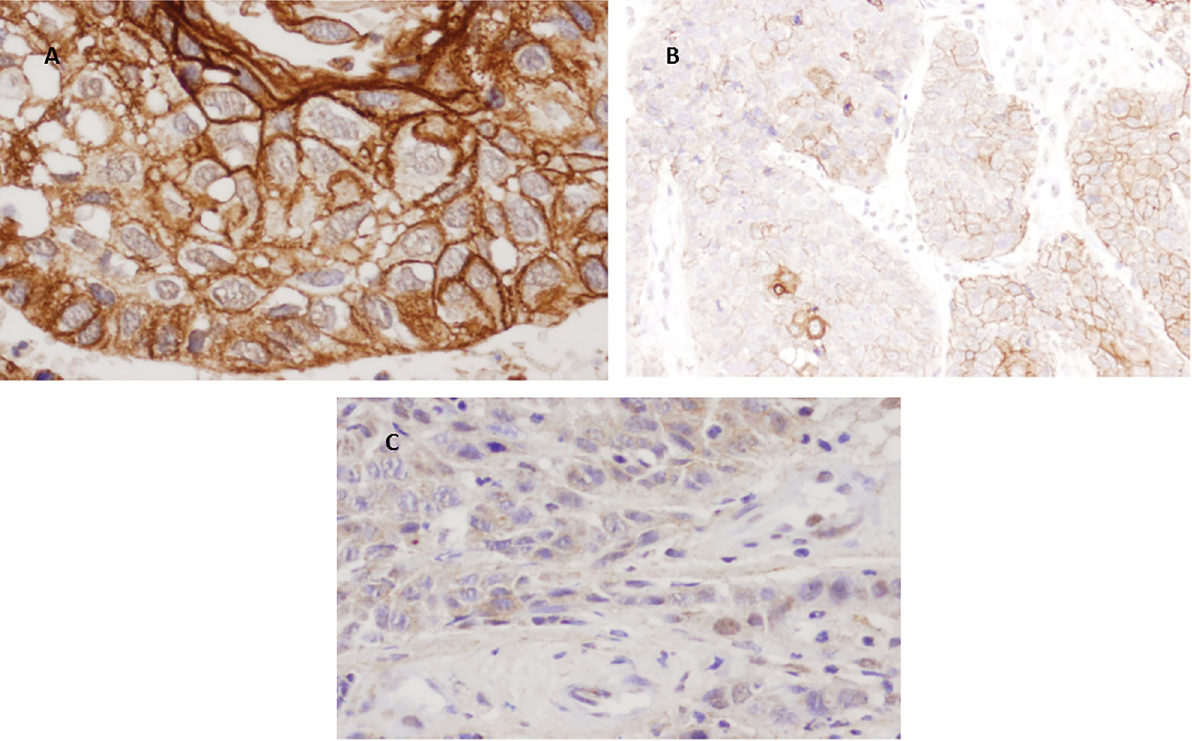
Figure 4. Immunohistochemical staining of DSG3 in SCC. (A) Well differentiated SCC with intense positivity mainly in cell membranes (40 (cid:5) ). (B) More heteroge- neous staining in cell membranes and some cytoplasms (20 (cid:5) ). (C) Faint cytoplasmic/nuclear staining in poorly differentiated area (40 (cid:5)